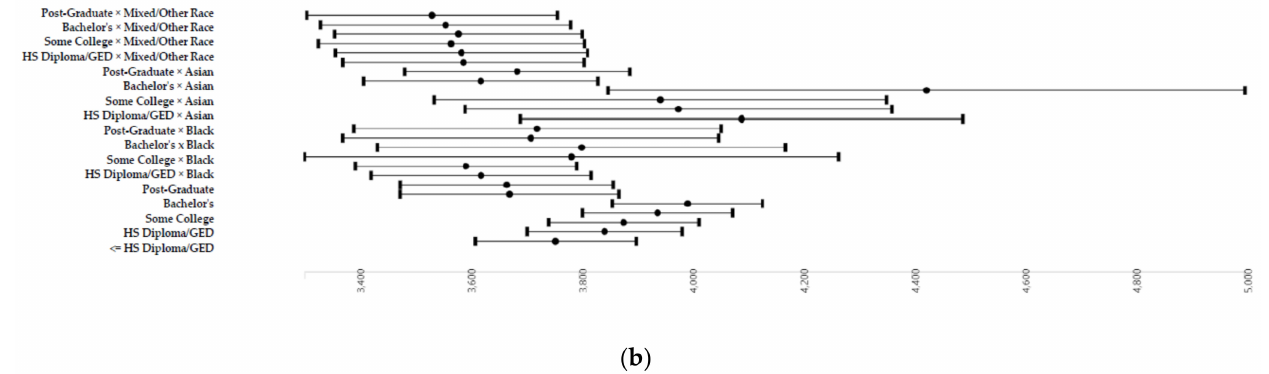
Figure A4. Association between parental education and children’s right superior temporal cortical surface area. In these figures, X represents children’s right superior temporal cortical surface area and Y represents parental education across racial groups. ( a ) Overall; ( b ) by race.